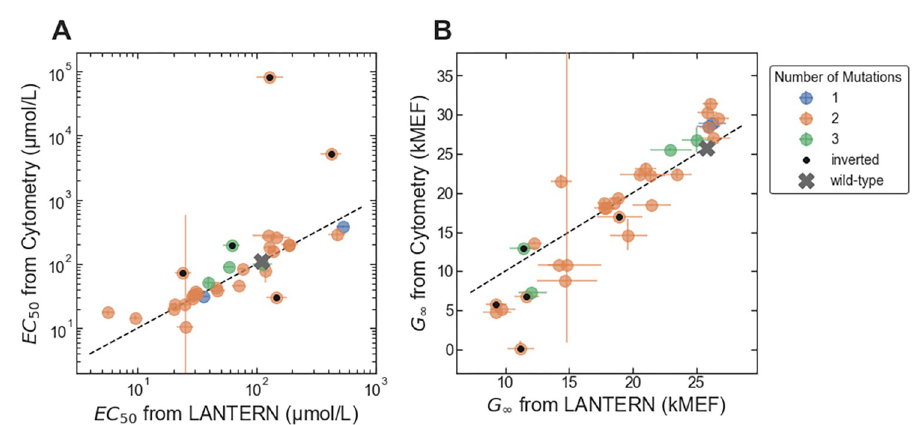
Fig 8. Accuracy of ML-enabled forward engineering. (A) EC 50 from the flow cytometry measurements plotted vs. EC 50 predicted by the LANTERN ML model. (B) G 1 from the flow cytometry measurements plotted vs. G 1 predicted by the LANTERN ML model. In each plot, results for LacI variants with different numbers of mutations are plotted with different colors. Results for the five unexpectedly inverted variants are marked with black dots. Error bars indicate ± one standard deviation.